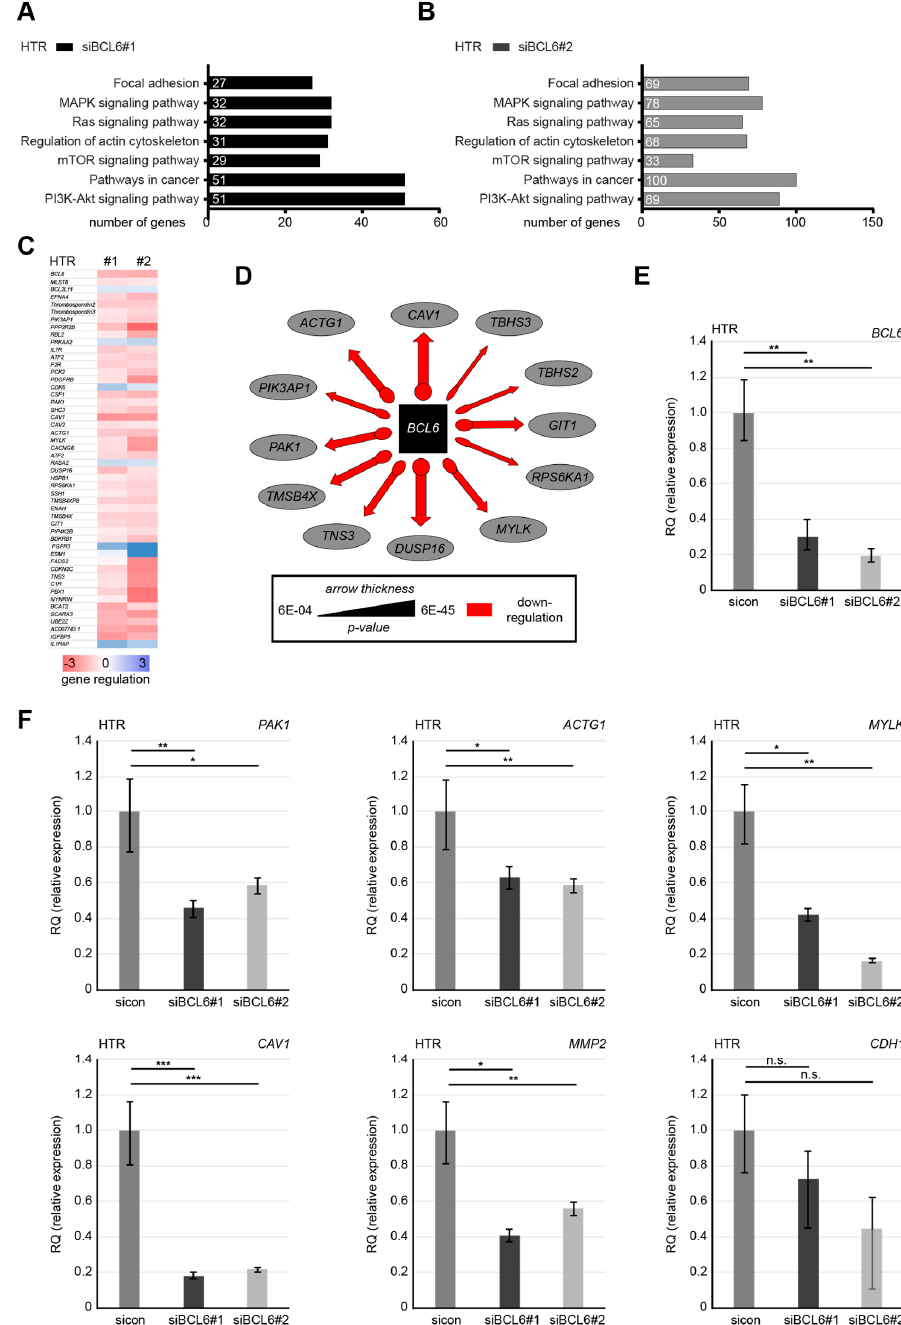
Figure 7. Reduction of BCL6 reduces the levels of multiple genes related to migratory machinery. ( A and B ) HTR cells were treated with sicon, siBCL6#1, or siBCL6#2 for 48 h and the RNA from three independent experiments was extracted for transcriptome analysis. The effects of siBCL6#1 ( A ) or siBCL6#2 ( B ) on different pathways were determined by gene ontology enrichment analysis using KEGG pathway enrichment analysis. ( C ) A heatmap of the most differently expressed genes. Gene expression was analyzed using the DESeq2 R package. Genes with a p -value < 0.01 and a fold change greater than 3 (blue color code) and below 3 (red color code), respectively, are included. ( D ) The most significant genes affected by the depletion of BCL6 in the context of migration are depicted. ( E )